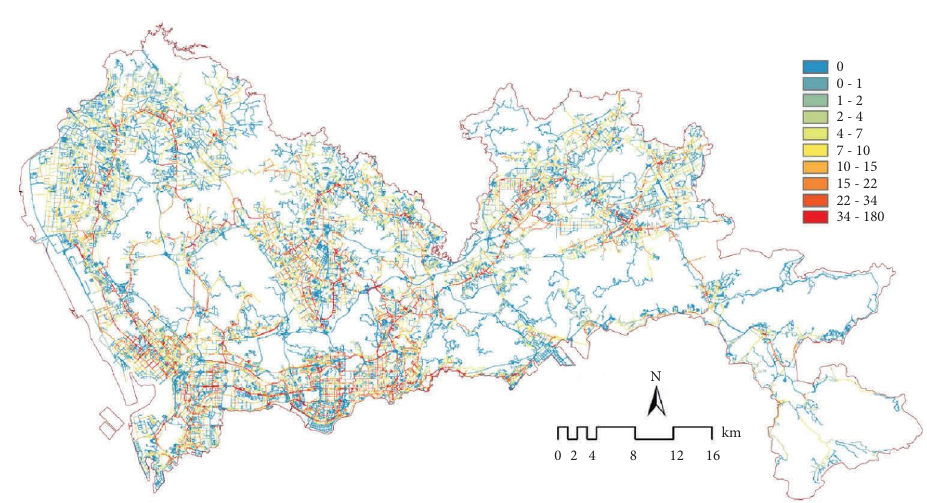
Figure 4: Number of surrounding